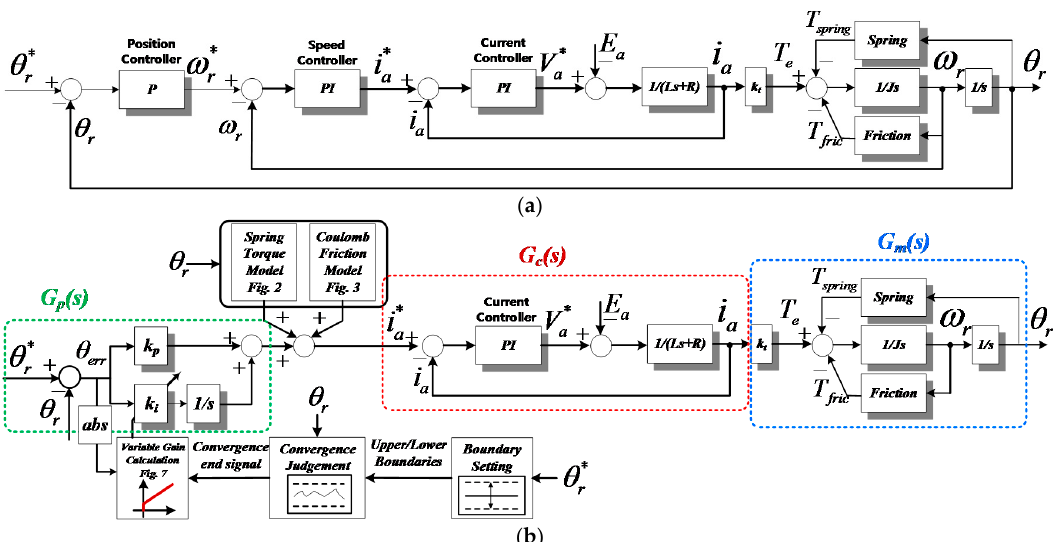
Figure 5. Position control method ( a ) P-PI controller [11] and the ( b ) proposed position controller.